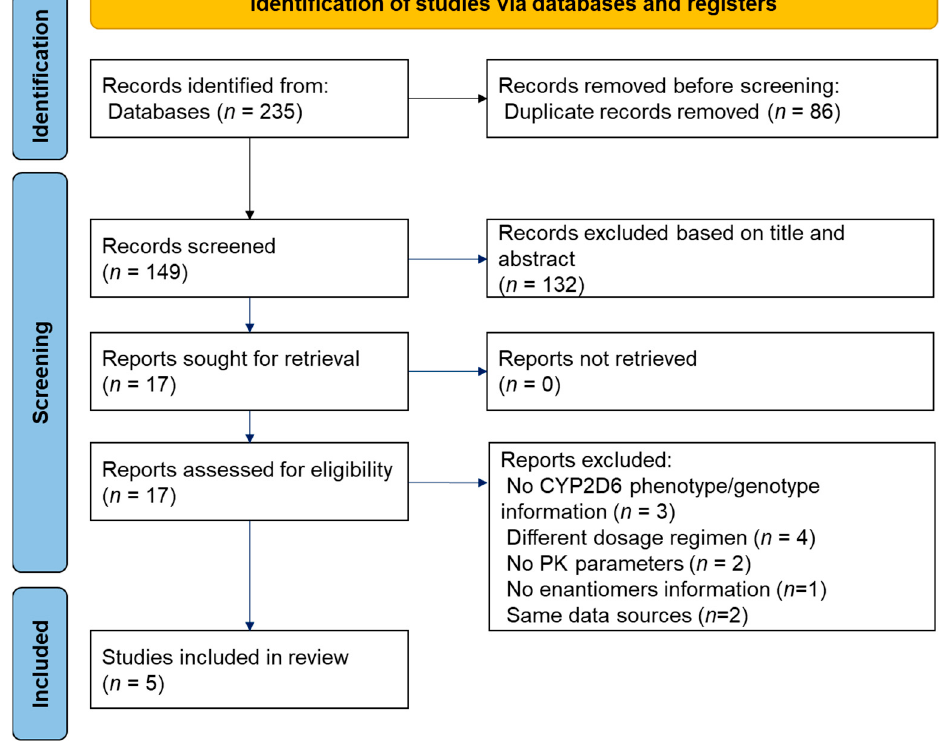
Figure 1. Flow chart of the selection process of all articles included in this meta-analysis.